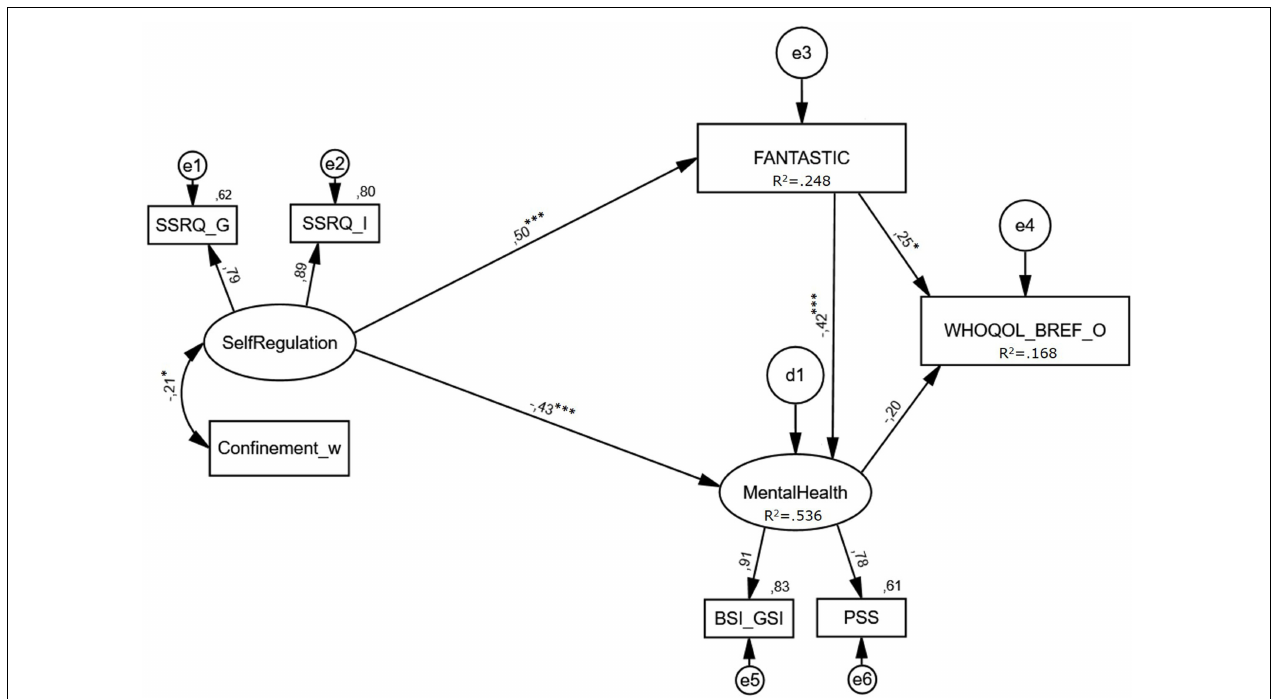
FIGURE 2 | Results of Structural Equation Modeling Analysis. d, disturbance term; e, error term of each indicator; SSRQ, Short Self-Regulation Questionnaire (G, goal setting; I, impulse control); Confinement_w, confinement duration in weeks; FANTASTIC, Fantastic Lifestyle Assessment; WHOQOL-BREF-O, World Health